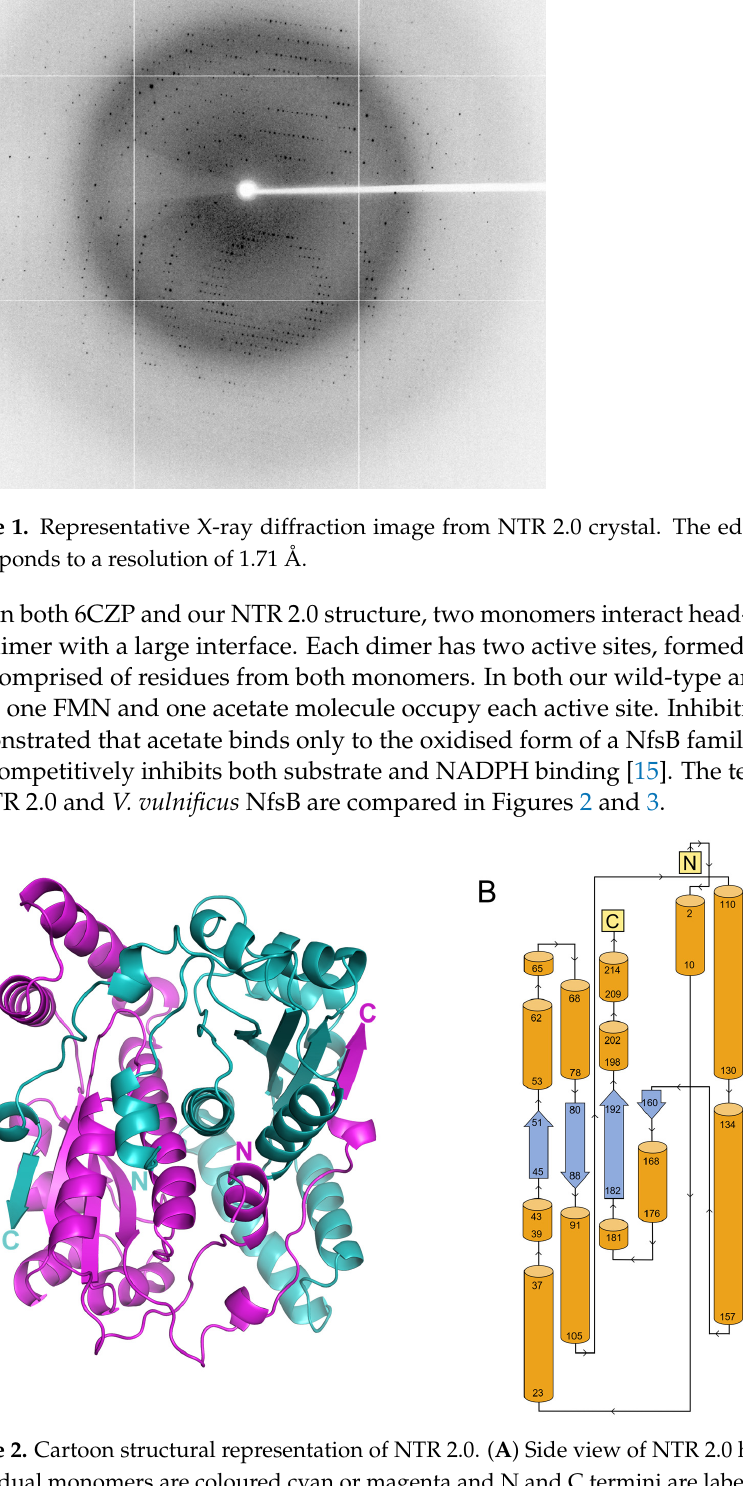
Figure 3. Cartoon overlay of the structures of NTR 2.0 and parental V. vulnificus NfsB. The parental enzyme is depicted in red and NTR 2.0 in cyan.